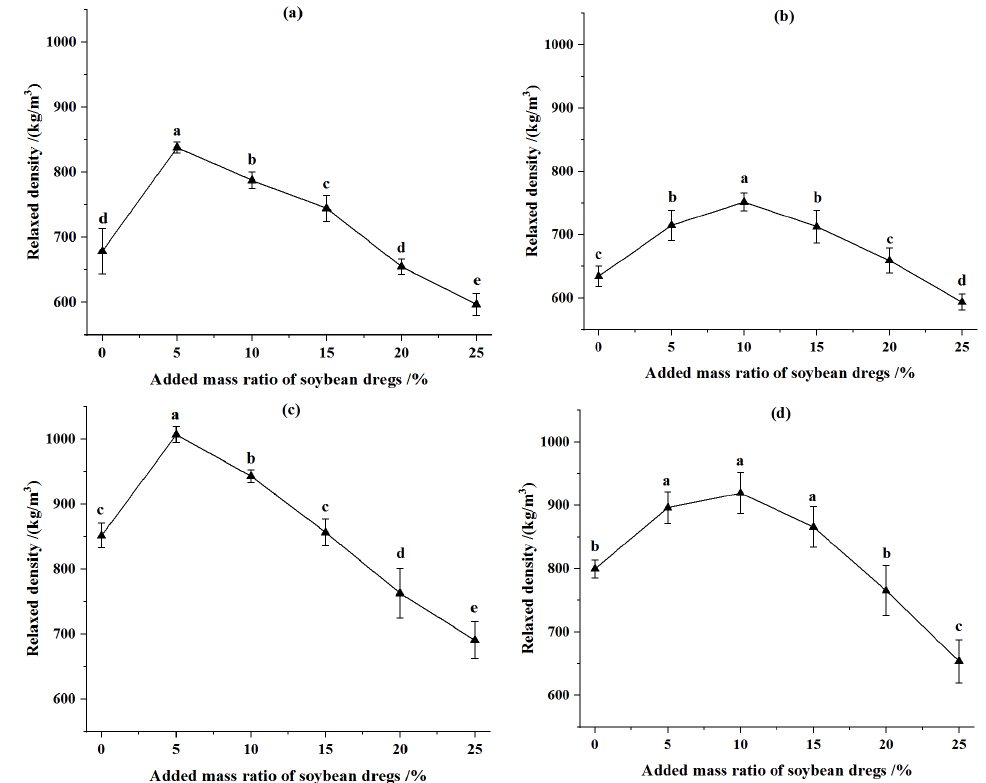
Figure 2. Effect of added mass ratio of fermented soybean dregs on relaxed density of pellets. ( a ) Particle size was 2 mm and compression displacement was 90 mm. ( b ) Particle size was 4 mm and compression displacement was 90 mm. ( c ) Particle size was 2 mm and compression displacement was 92 mm. ( d ) Particle size was 4 mm and compression displacement was 92 mm. Note: Different letters in the same line chart indicate a significant difference between the data ( p < 0.05).